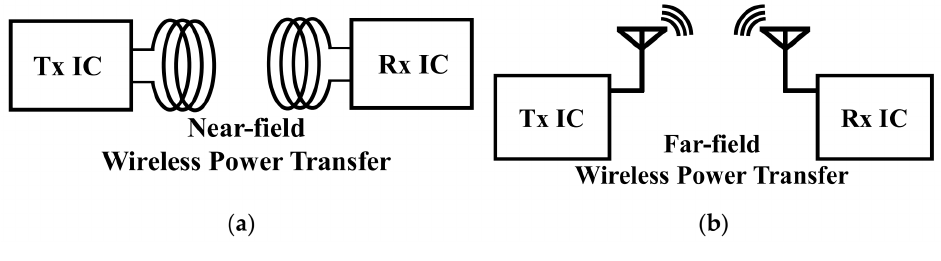
Figure 1. Wireless power transfer technique, ( a ) Near-field, ( b ) Far-field